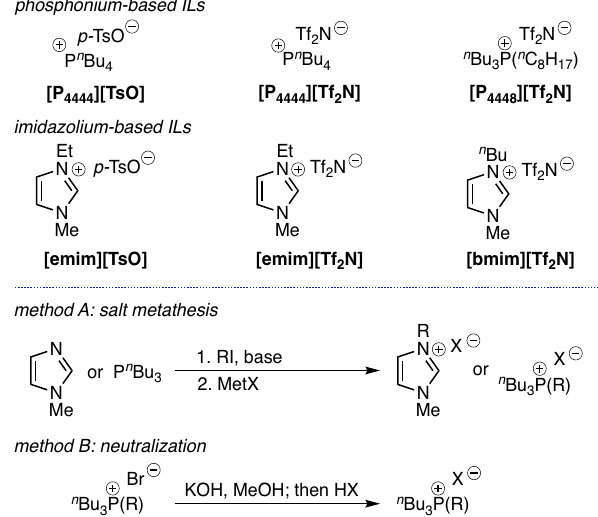
Fig. 2 Different TSIL candidates investigated for DSE